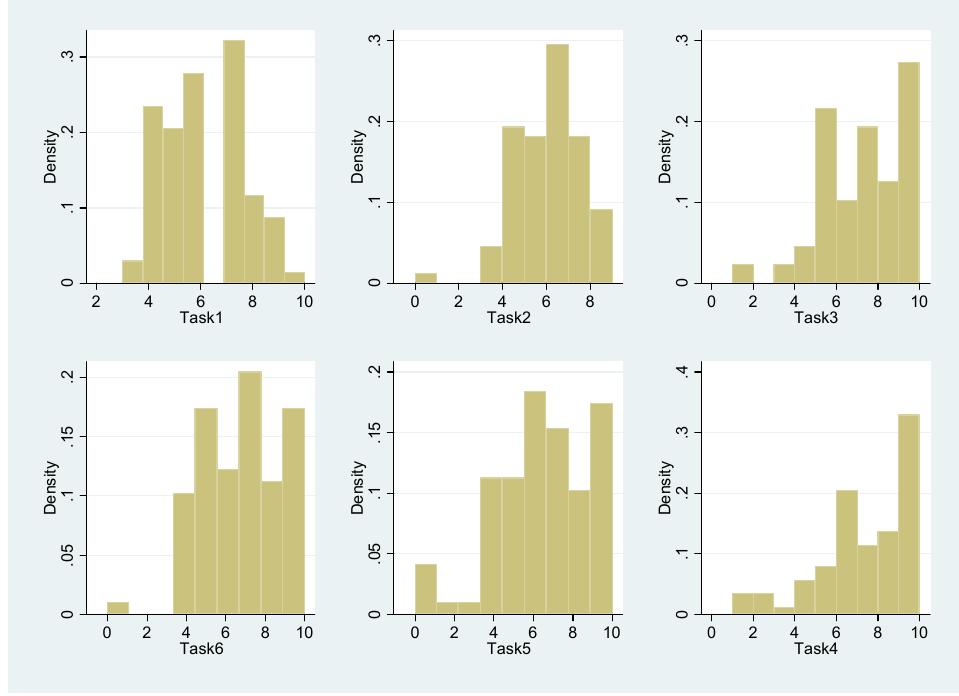
Figure A3. Histograms of the switching points and choice numbers. Selected by the subjects, which represent the distributions of the degrees of risk aversion.